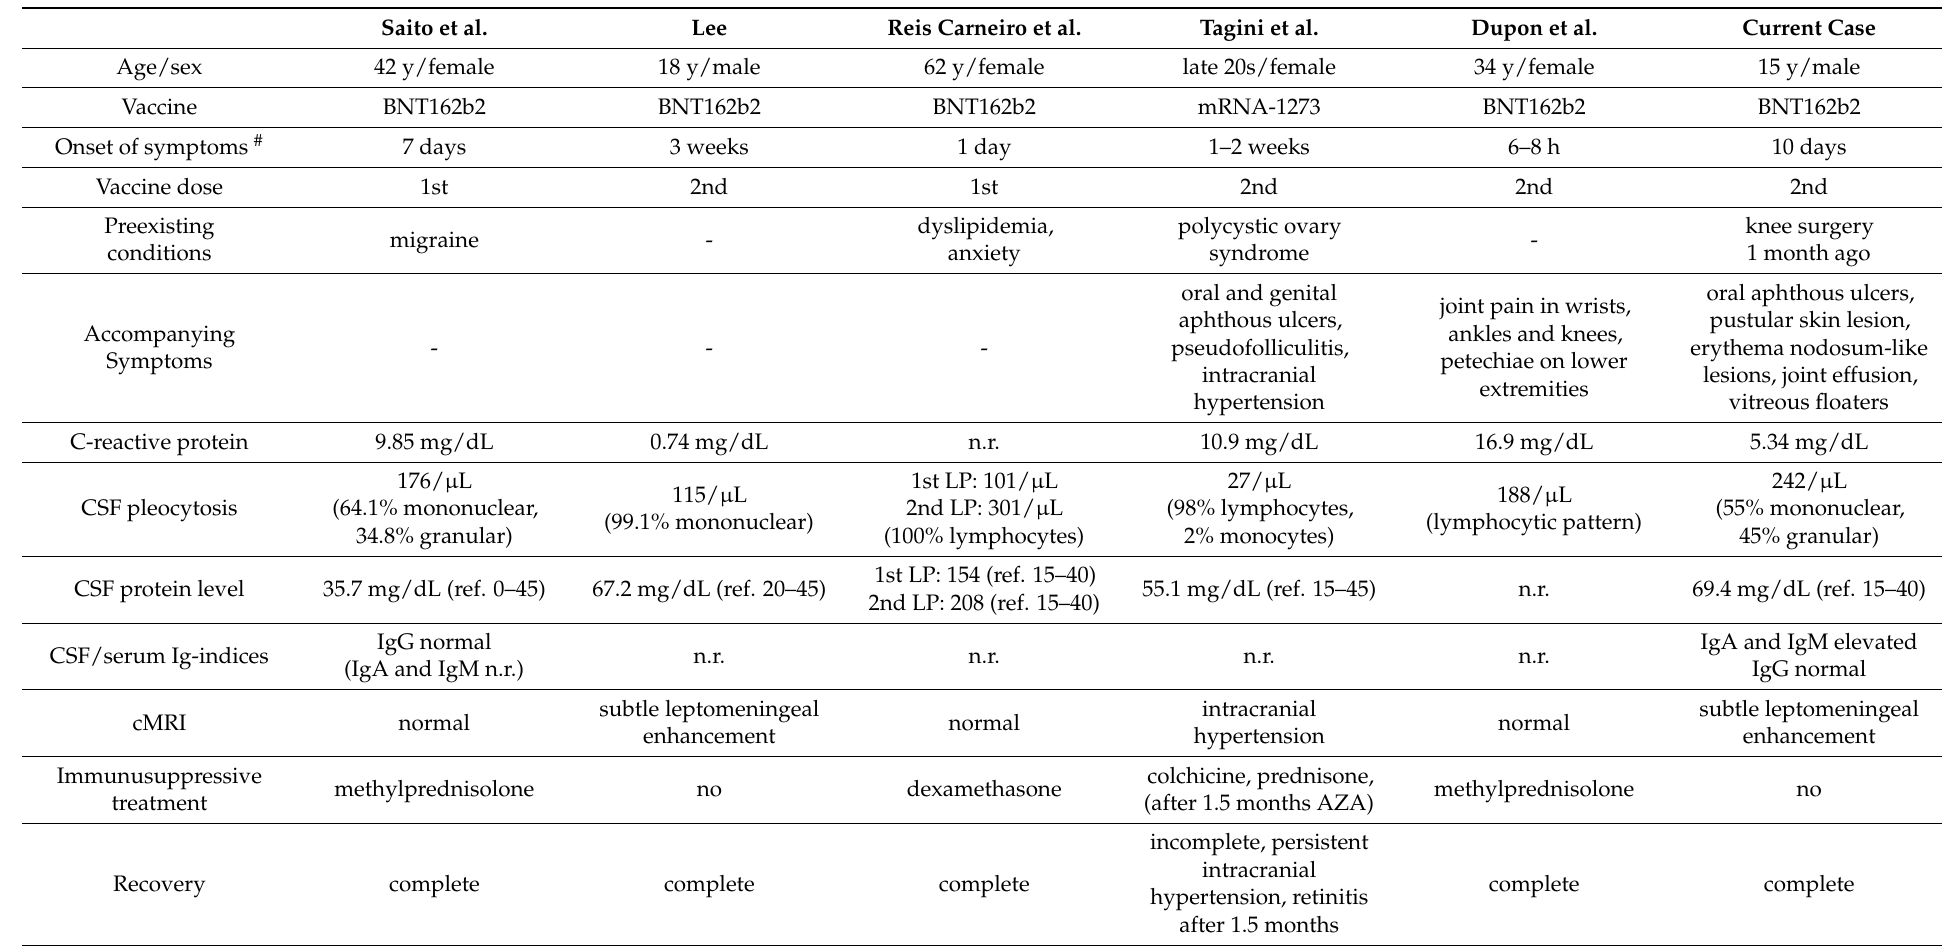
Table 1. Reported patients with aseptic meningitis after